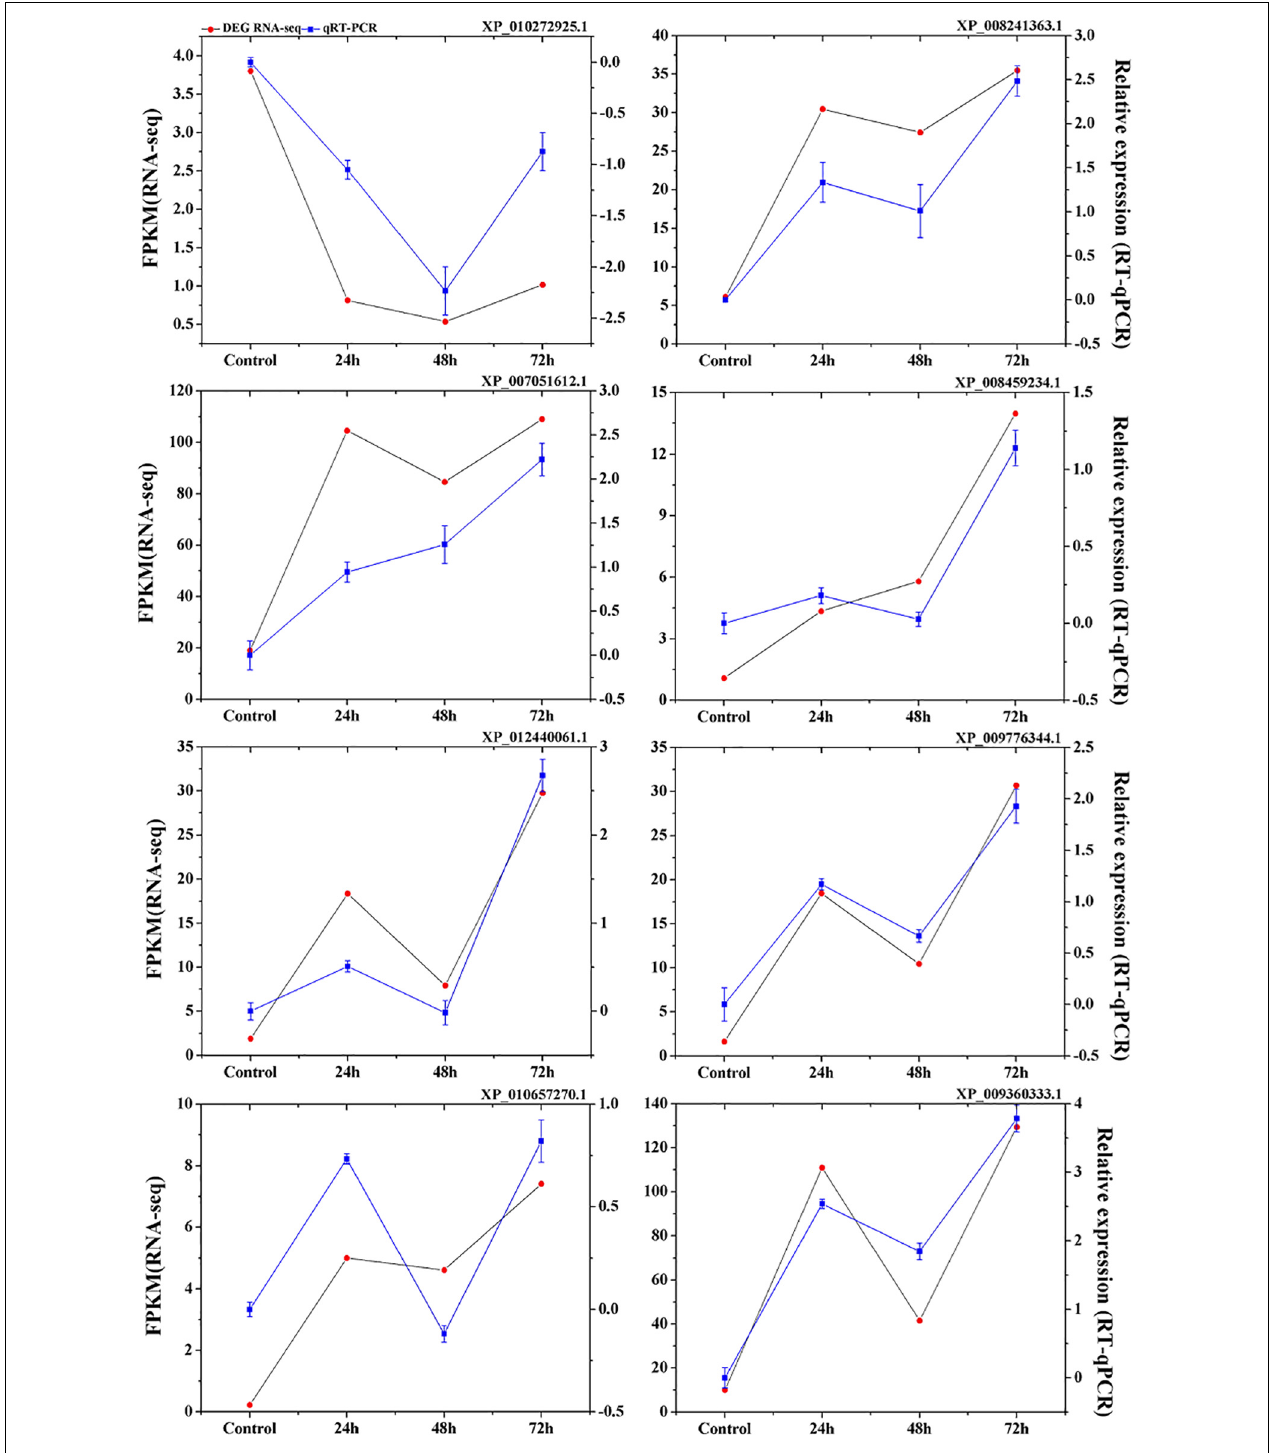
FIGURE 3 | Verification of eight selected DEGs by qRT-PCR. Comparison of RNA-seq data (Red point) with qRT-PCR data (Blue point). The normalized expression level (FPKM; expected number of Fragments Per Kilobase of transcript sequence per Millions base pairs sequenced) of RNA-seq is indicated on the y -axis to the left. The relative qRT-PCR expression level of selected DEGs is shown on the y -axis to the right. β -actin was used as the internal control. Three biological replicates were used.